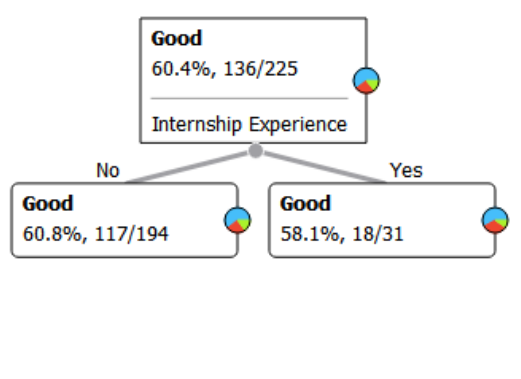
Fig. B4. Classification Tree with internship experience